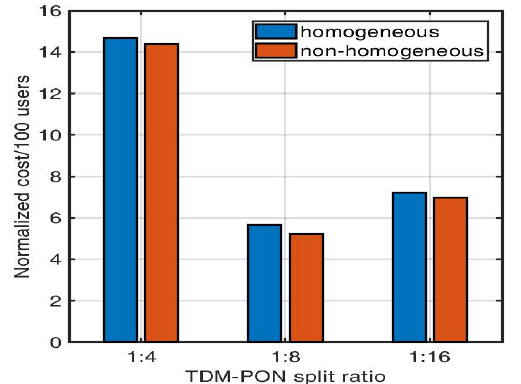
Figure 9. Comparison of normalized cloudlet deployment cost/100 users with homogeneous and non-homogeneous network over a circular area with diameter = 4 km, population density = 4000 people/km 2 , and D QoS = 1